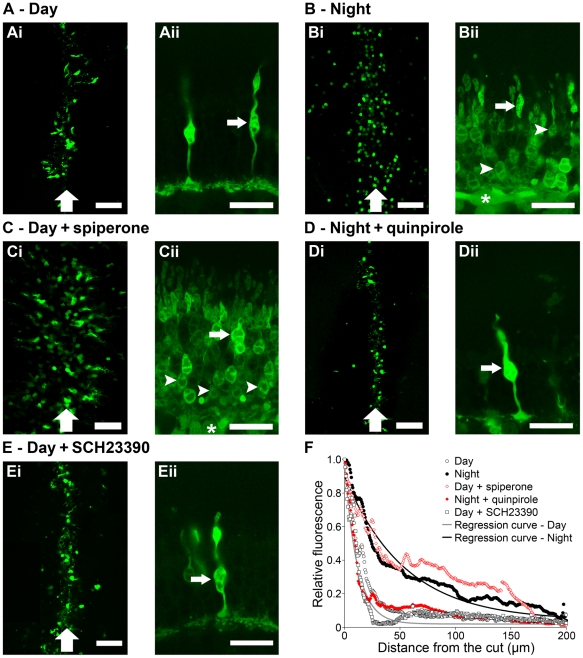
Tracer coupling between rabbit rod and cone photoreceptor cells varies with the time of day and D2 receptor activity.
A-E, Typical examples of photoreceptor cell tracer coupling obtained under dark-adapted conditions during the day (A), night (B), and day in the presence of spiperone (10 µM) (C), night in the presence of quinpirole (1 µM) (D), and day in the presence of SCH23390 (10 µM) (E). Shown are confocal images of whole-mount rabbit retinas taken parallel to the retinal surface at the level of the photoreceptor inner segments near the cut (Ai-Ei) and detailed perpendicular views at higher magnification of the 3D reconstruction of the labeled photoreceptor cells (Aii-Eii). The micrographs in Aii-Eii show labeled photoreceptor cells in images that range along the horizontal axis from the cuts (leftmost edge of the micrographs) to 50 µm from the cuts (rightmost edge). In addition, at the bottom of the micrographs cone pedicles are visible in Aii, Dii and Eii, and horizontal cells/bipolar cells are indicated (asterisks) in Bii and Cii proximal to the photoreceptors. Large vertical arrows indicate the location of the cuts in Ai-Ei. Some cones (small arrows) and rods (arrowheads) are indicated in Aii-Eii. Rod cell bodies are located in the innermost half of the outer nuclear layer, whereas cone cell bodies are typically located in the outermost half of the outer nuclear layer [49]. Scale bar = 50 µm (Ai-Ei); 20 µm (Aii-Eii). F, Averaged normalized fluorescence in the photoreceptor cell layer as a function of the distance from the cut under dark-adapted conditions during the day (open circles; n = 6), night (filled circles; n = 4), and during the day in the presence of spiperone (open diamonds; n = 4) or SCH23390 (open squares; n = 2), and night in the presence of quinpirole (filled diamonds; n = 4). Curves generated from the non-linear analysis of the data during the day (grey curve) and night (black curve) are also shown. Data points represent averaged data from n experiments (1 retina/condition/experiment) ± SEM.